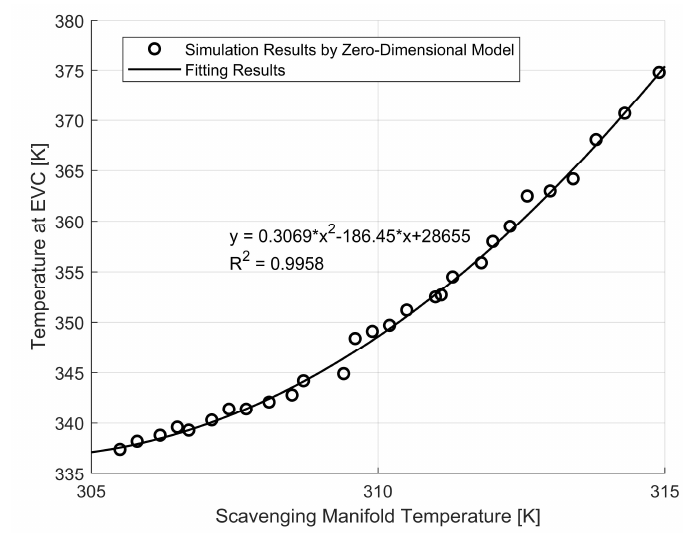
Figure 19. Fitting result between scavenging manifold temperature and in-cylinder temperature at EVC based on the 0-D model.